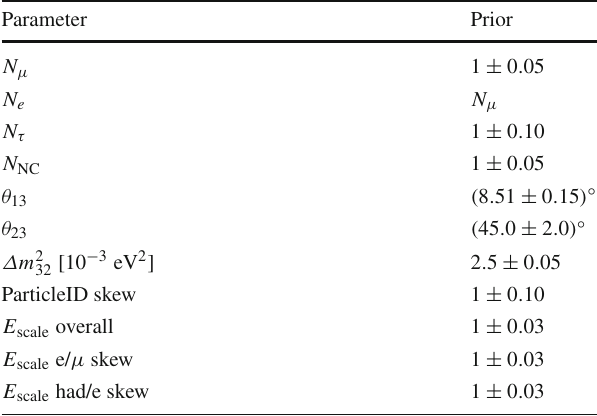
Fig. 8 Sensitivity of P2O to the neutrino mass ordering (NMO) as a function of the θ 23 mixing angle after 3 years of running with a 90 kW beam (positive beam polarity). The θ 23 and δ CP values chosen provide the most and the least favourable scenarios for both normal (NO) and inverted mass ordering (IO). One year of running with the 90 kW beam corresponds to ≈ 0 . 8 × 10 20 protons on target (POT)